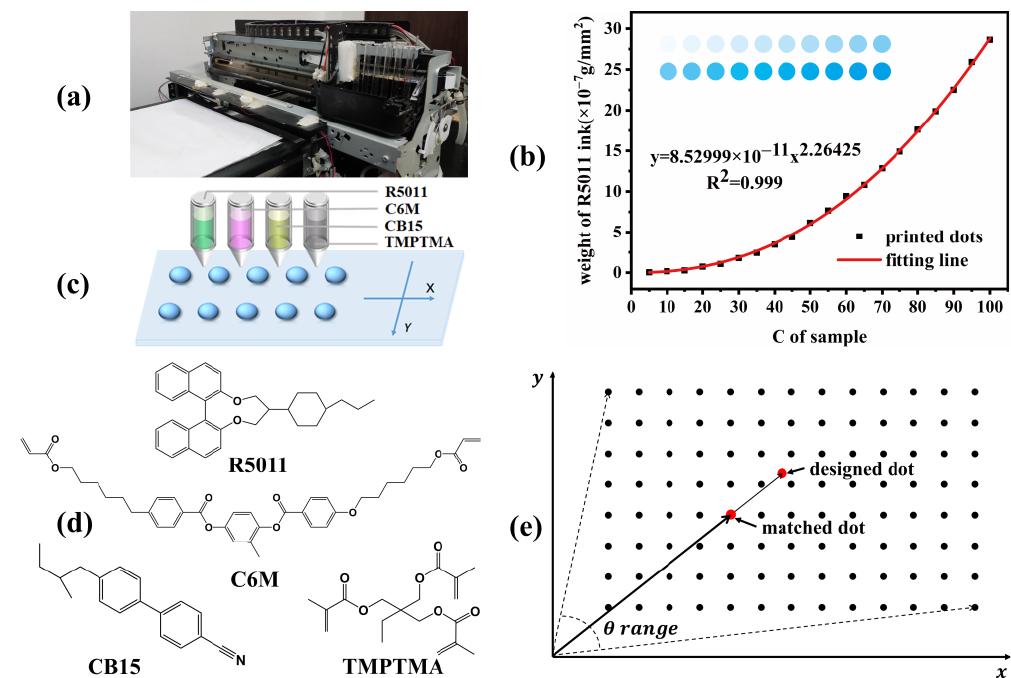
Figure 1. ( a , c ) Schematic diagram of inkjet printer device and printing principle. ( b ) Standard curve of 5 wt% R5011 solution for inkjet printing in C channel. ( d ) The molecular structure of the inkjet printing component used. ( e ) Schematic diagram of vector matching method.